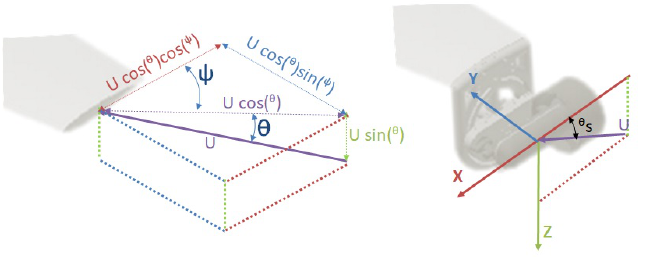
Figure 4. Vector decomposition of the lateral propulsion vector ( left ) and the propulsion vector of the lateral thrusters of Guanay II AUV ( right ).